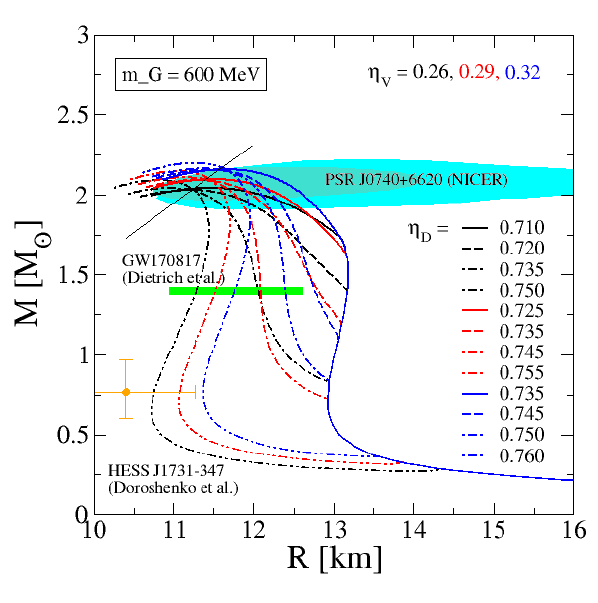
Figure 5. Same as the right panel of Fig. 1 but for DD2Y-T instead of DD2p40 and the confining RDF approach replacing the nlNJL quark matter EOS. A smaller sample of η V and η D values is used to demonstrate the existence and location of the SP train for the slope ξ = δη V / ( δη D ) = 0 of simultaneous variation of the Lagrangian